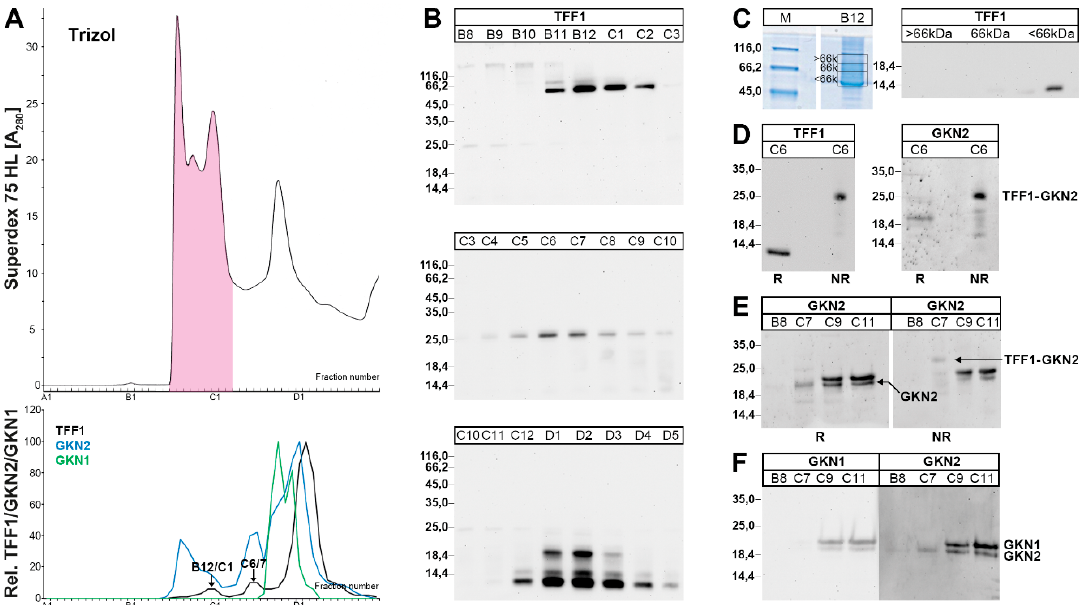
Figure 3. Analysis of a human gastric corpus extract (M C -577) after TRIzol ® extraction. ( A ) Elution profile after SEC on a Superdex 75 HL column, as determined by absorbance at 280 nm (PAS-positive mucin fractions: pink). Underneath: Distribution of the relative TFF1 (black), GKN2 (blue), and GKN1 (green) immunoreactivities respectively, as determined by Western blot analysis under reducing conditions and semi-quantitative analysis of the typical monomeric band intensities. ( B ) 15% SDS-PAGE (non-reducing conditions) and subsequent Western blot analysis of fractions B8-D5 concerning TFF1 (post-in-gel reduction). The molecular mass standard is indicated on the left. ( C ) 15% SDS-PAGE (non-reducing conditions) and Coomassie staining of fraction B12. Then, the bands >66k, 66k, and <66k were cut out as indicated, proteins were eluted, subject to reducing 15% SDS-PAGE, and the TFF1 content was tested by Western blot analysis. ( D ) 15% SDS-PAGE and subsequent Western blot analysis of fraction C6. Samples were analyzed under reducing (R) or non-reducing (NR) conditions for their TFF1 and GKN2 immunoreactivities, respectively. ( E ) 15% SDS-PAGE and subsequent Western blot analysis of the fractions B8, C7, C9, and C11. Samples were analyzed under reducing (R) or non-reducing (NR) conditions respectively, for their GKN2 immunoreactivity. ( F ) 15% SDS-PAGE